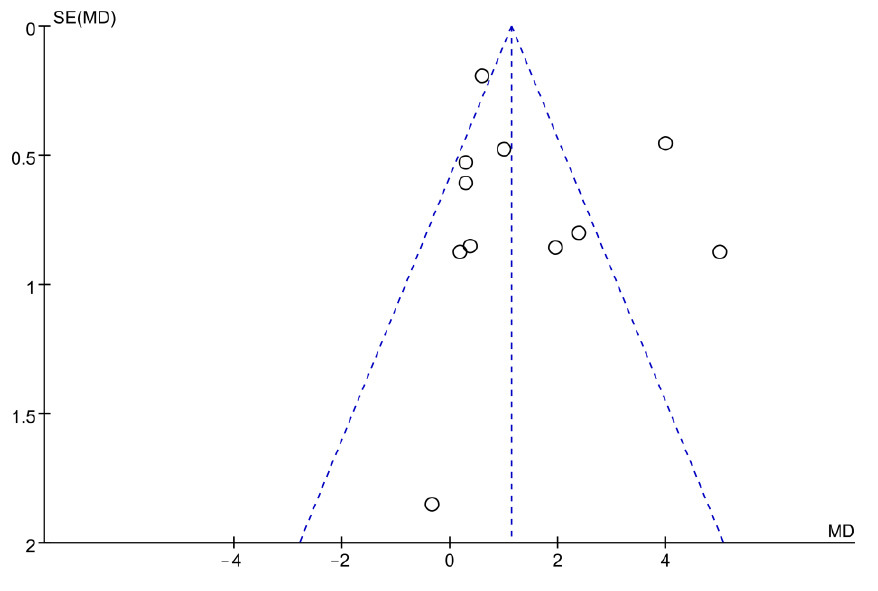
Figure 3. Funnel plot. Table 1. Results of Egger’s test.